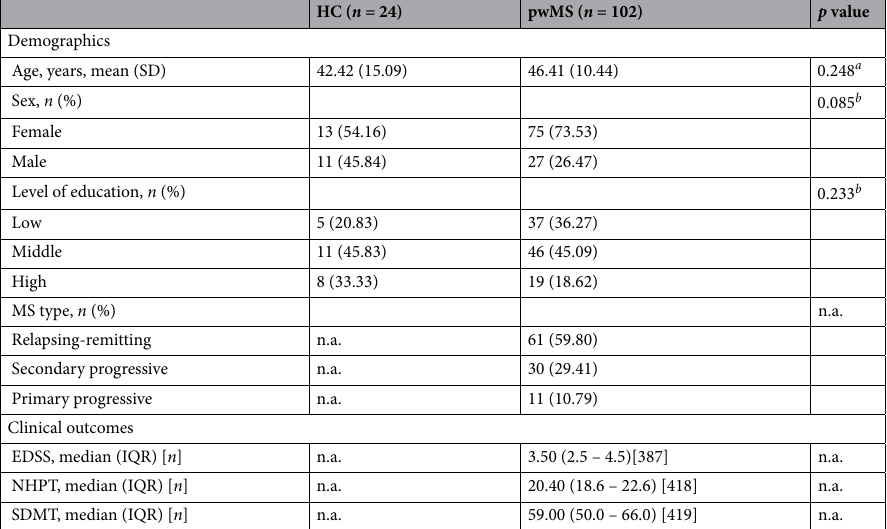
Table 1. Summary of the study cohort, demographic and clinical characteristics concerning each group (HC and pwMS). Clinical outcomes are also provided and shown solely for pwMS since such assessments were not carried out on healthy subjects. More information regarding the education demographics can be found in the supplementary material Table A4. HC healthy controls; pwMS people with multiple sclerosis; EDSS